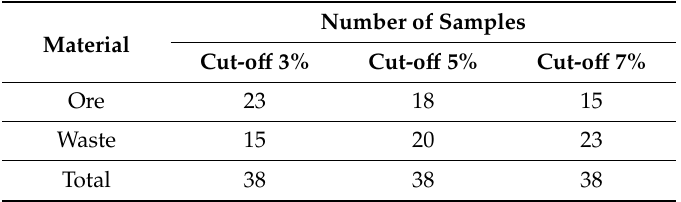
Table 3. Summary of the number of samples in the ore and waste classes at 3%, 5% and 7% cut-o ff